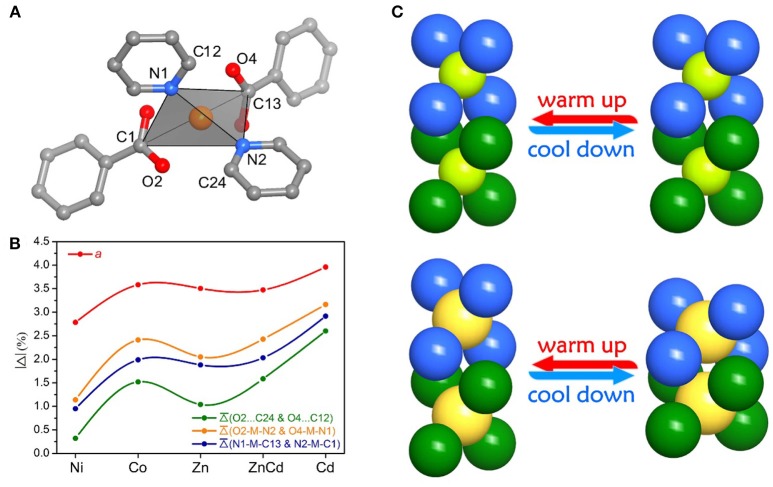
Elucidation of the thermal expansion mechanism for the fence stacking. (A) The tetrahedral building unit. (B) The selected parameters and variations for the geometry of the tetrahedral building unit and the interlayer separation/interaction. (C) Schematic views of thermal expansion upon the change of steric hindrance and metal ions.